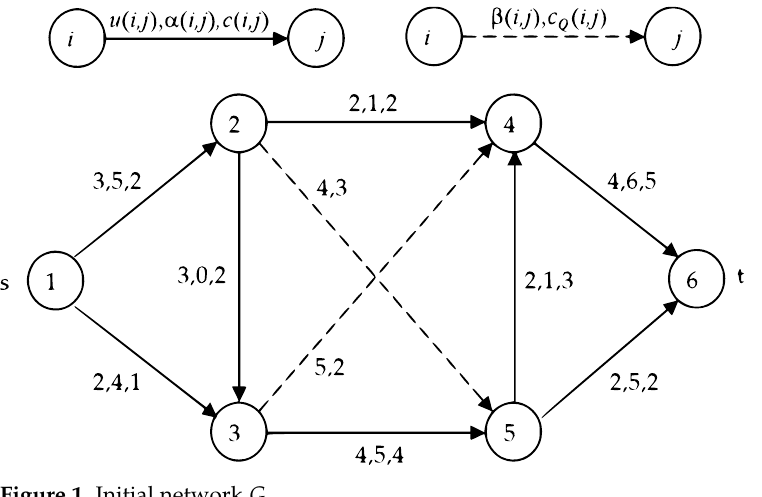
Figure 1. Initial network G .